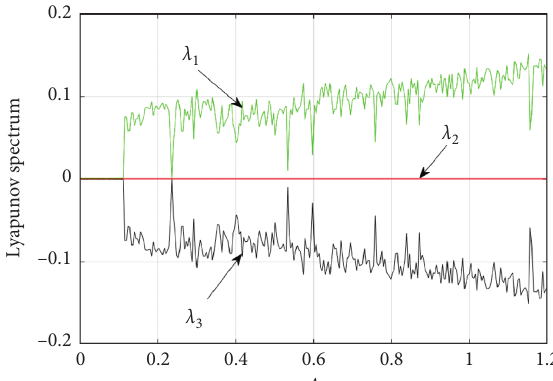
Figure 5: Lyapunov exponent spectrum for system (28) versus forcing amplitude A when w � 0 . 7. This graph is plotted with initial condition (1,